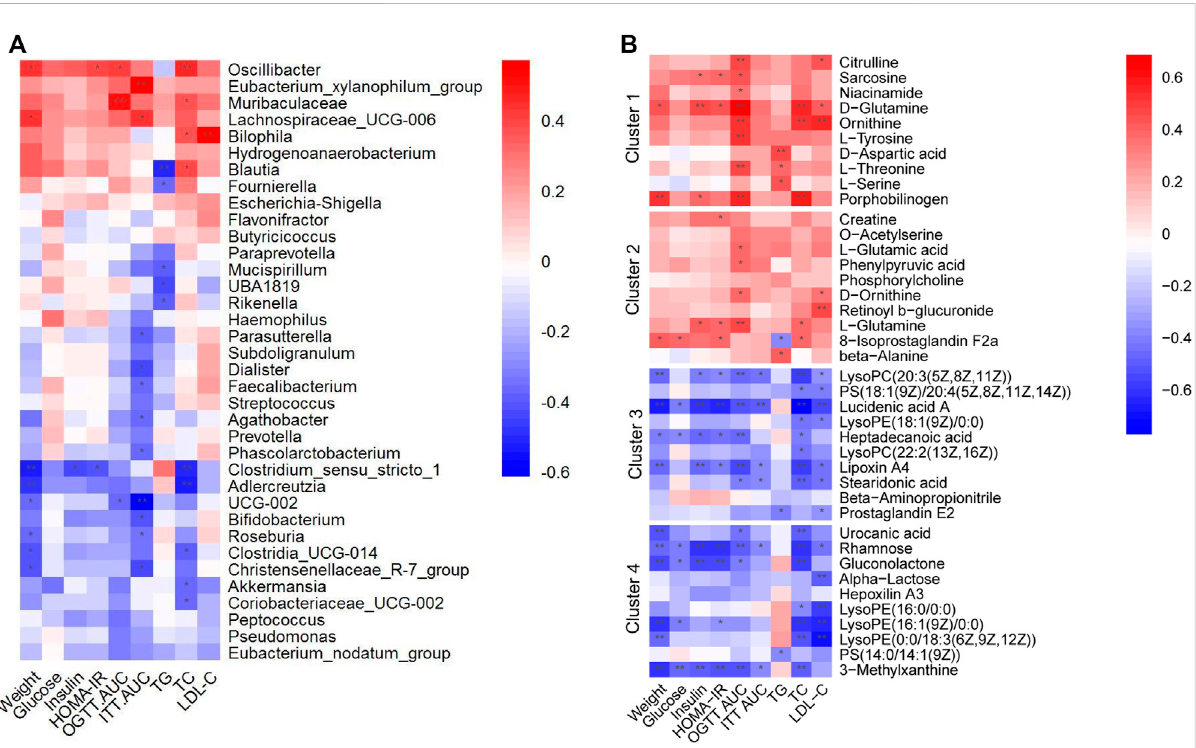
FIGURE 7 Heatmaps of Spearman correlation analysis between altered gut microbes, gut metabolites and glucolipid metabolic parameters. (A) Correlation analysis between altered gut microbes and glucolipid metabolic parameters. (B) Correlation analysis between altered gut metabolites and glucolipid metabolic parameters. Crosses show the correlation coef fi cients (r), * p < 0.05, ** p <